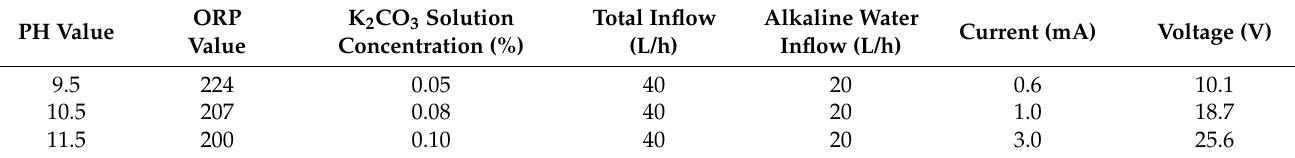
Figure 2. Preparation steps of AEW. Table 4. Preparation parameters of AEW with different pH values.